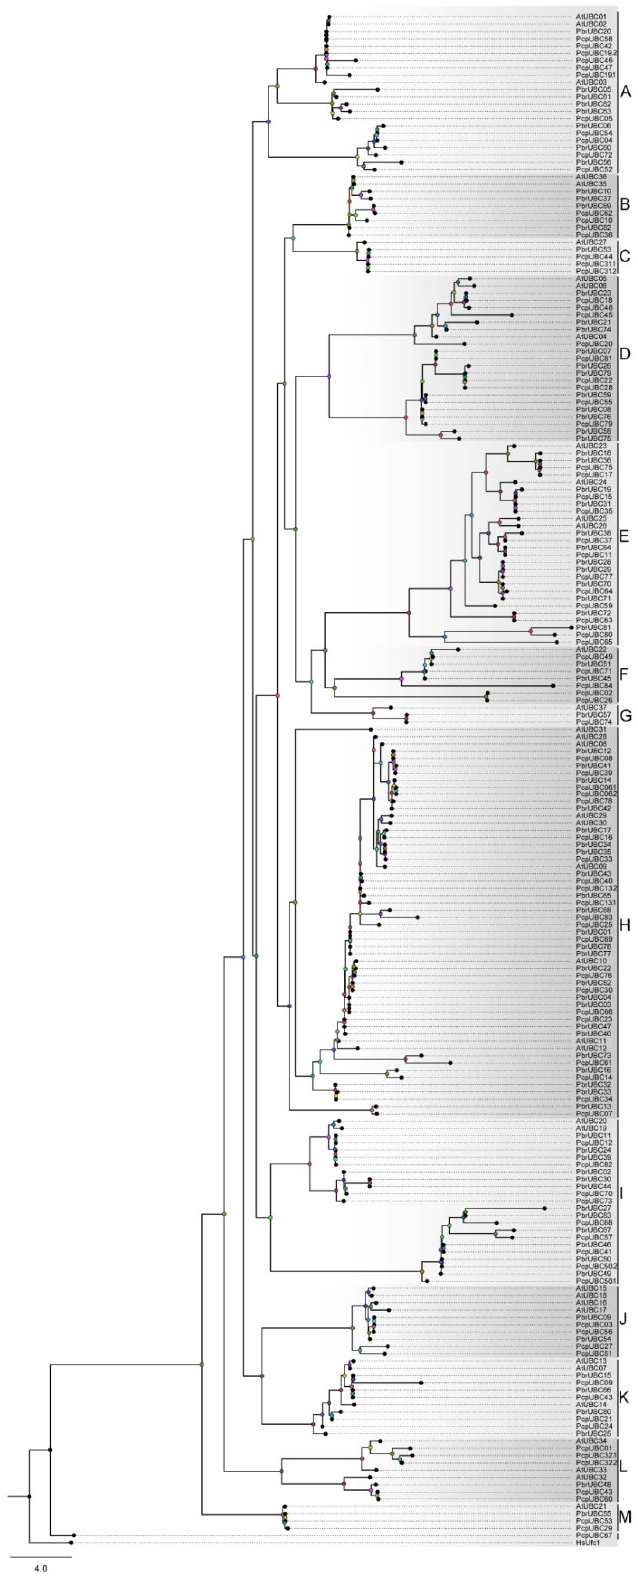
Figure 1. Phylogenetic tree of UBC genes from P. bretschneideri , P. communis , and A. thaliana . The phylogenetic tree was built using IQ-TREE software, and HsUfc1 from Homo sapiens was used as the out-group. According to published articles, the ML tree could be divided into 13 subfamilies